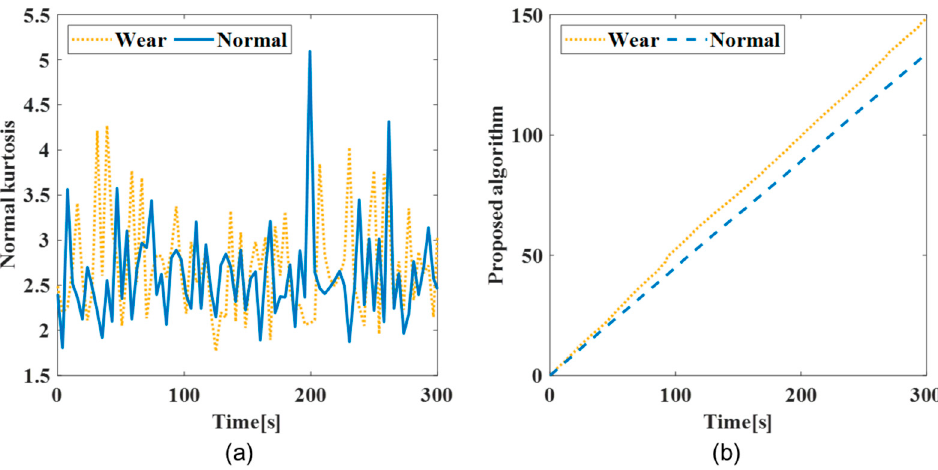
Figure 7. Difference between normal and wear tool in SM45C machining process: ( a ) kurtosis; ( b ) kurtosis using proposed algorithm.